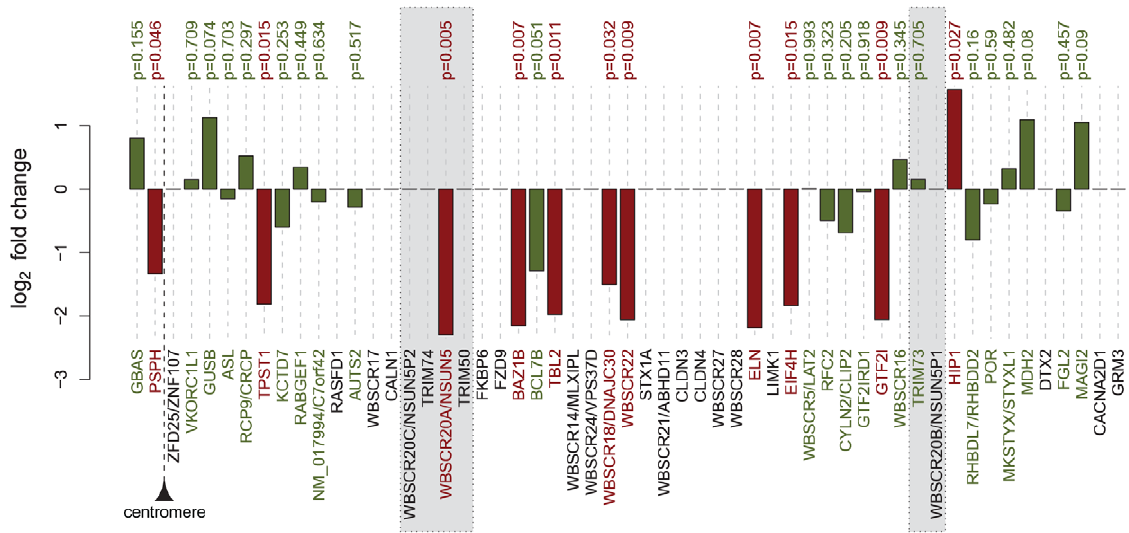
Figure 1. Differential expression of the WBS hemizygous and flanking genes. Genes are ordered according to their chromosomal position. Shaded areas represent the LCRs flanking the deletion. Gene names are indicated at the bottom and corresponding differential expression P -values at the top. For genes with multiple probesets the most significant P -value is considered. Red bars indicate significance ( P , 0.05). Genes without a P - value were not detected on the array and thus not tested.